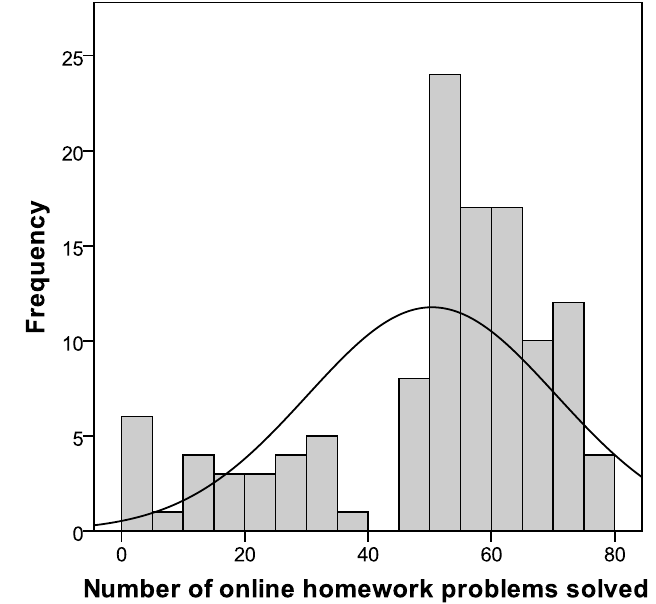
Fig. 2. Distribution of the number of online homework problems